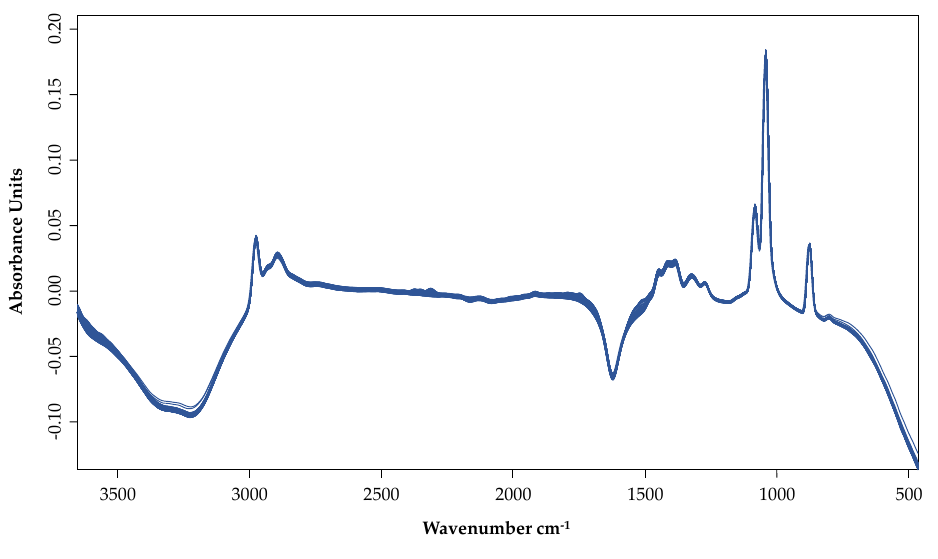
Figure 5 . FTIR-ATR absorbance spectra of all AUS samples. Figure 5. FTIR-ATR absorbance spectra of all AUS samples.